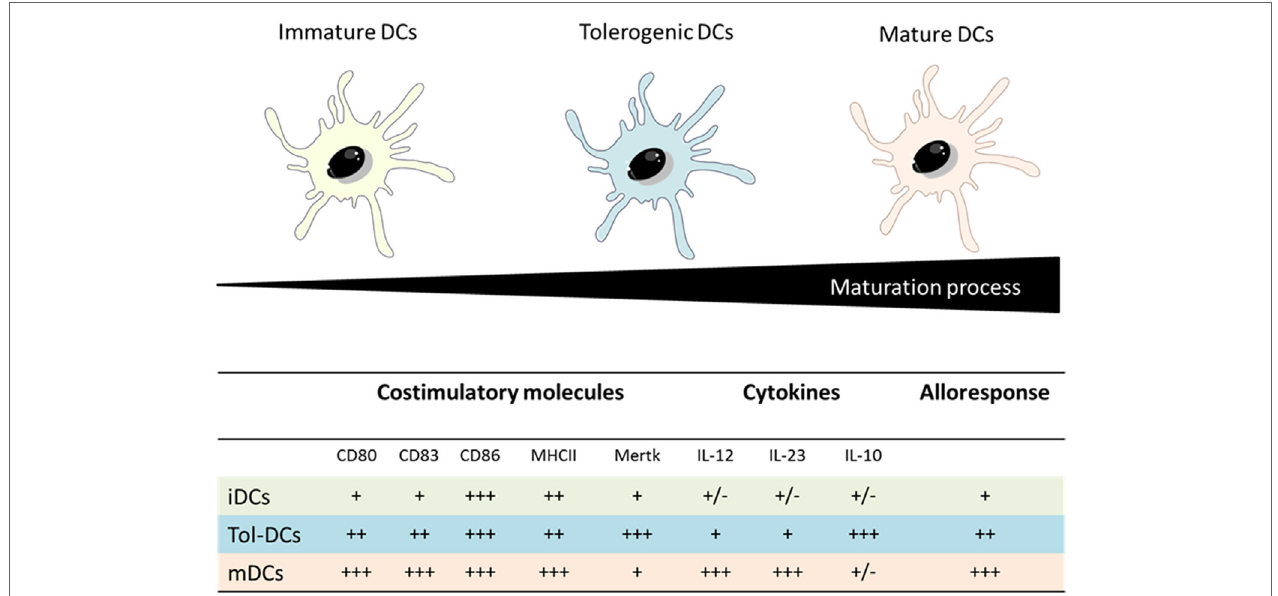
FigURe 5 | Comparison between iDCs, tolerogenic DCs and mature DCs properties. Adapted from: Hubo et al.